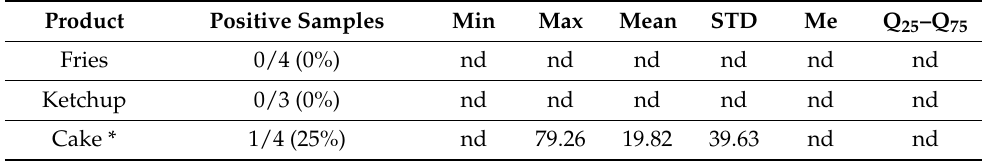
Table 1. The level of gluten contamination in products purchased in gastronomic point